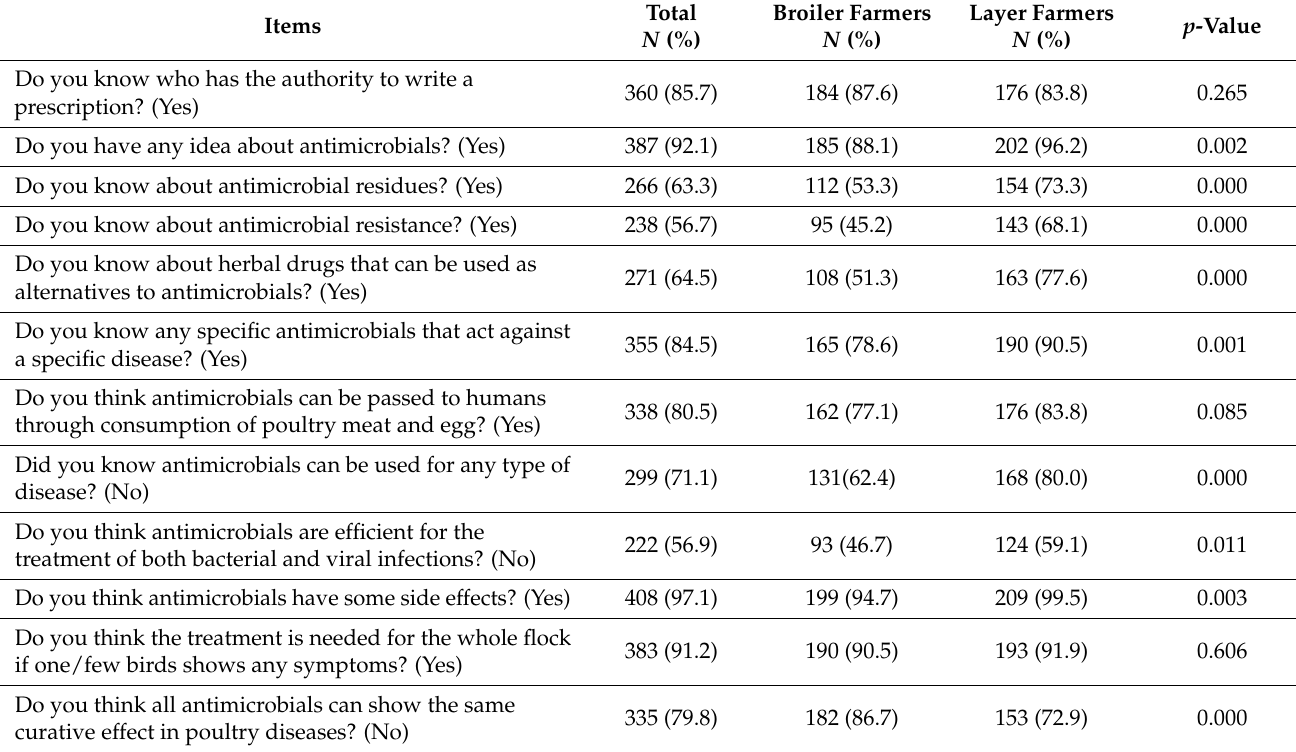
Table 2. Knowledge of AMU and AMR of broiler and layer